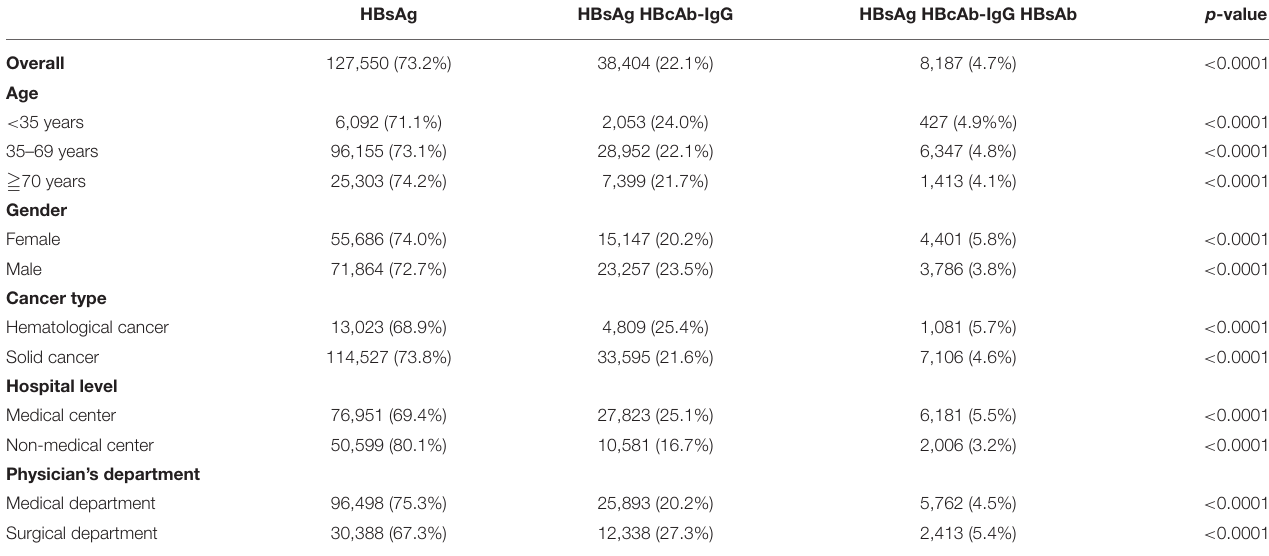
TABLE 3 | Practice patterns of HBV screening in whole patients and subgroup